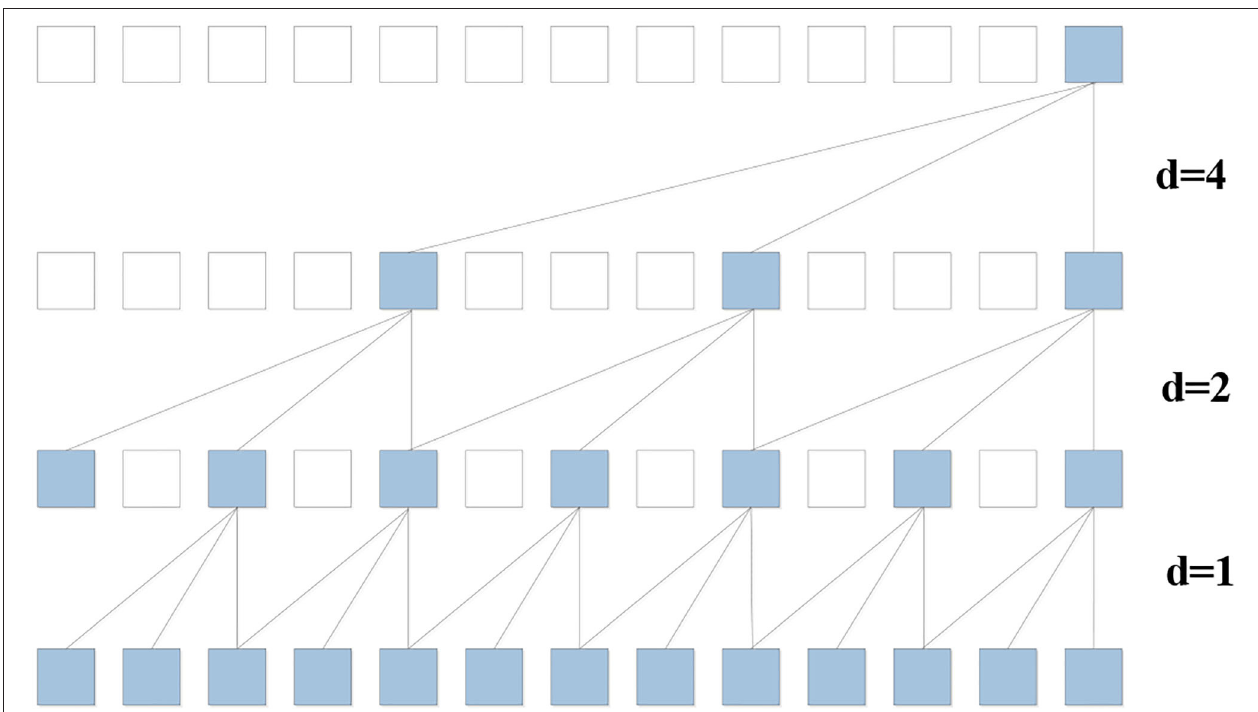
FIGURE 5 | Time convolution net with kernel size three and dilation factor d